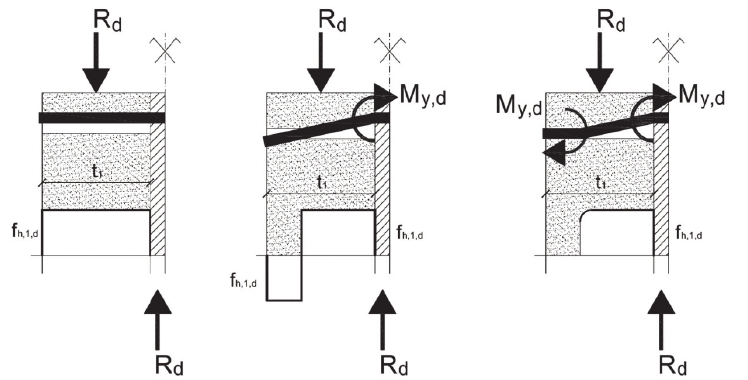
Figure 2: Failure mechanisms of double-shear dowel type steel to timber